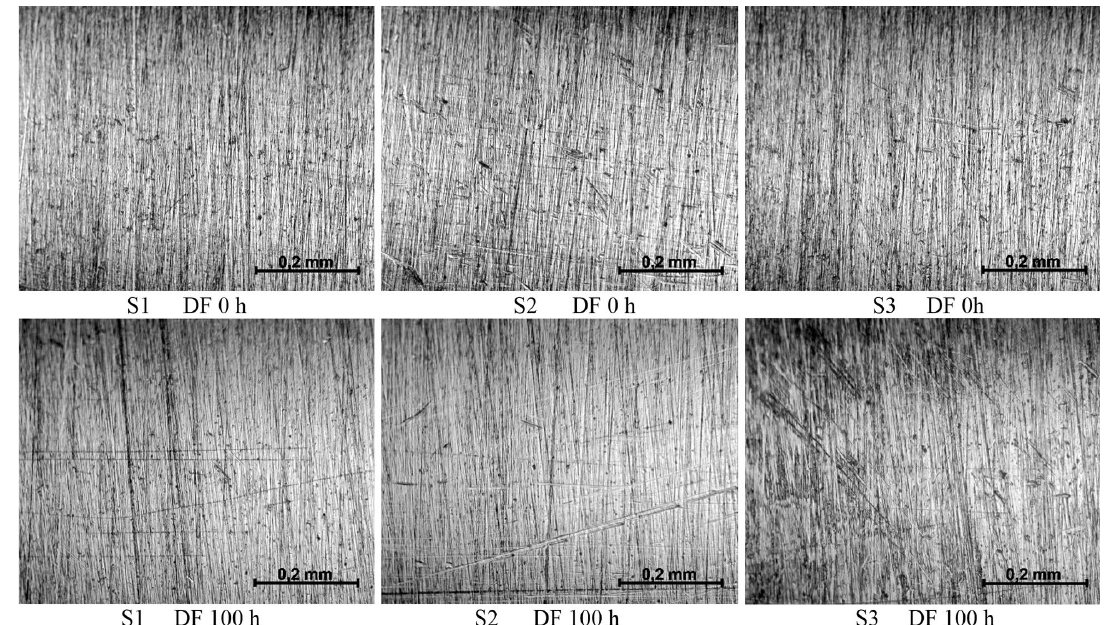
Fig. 6. The pictures of plungers surfaces S1, S2, S3, working with